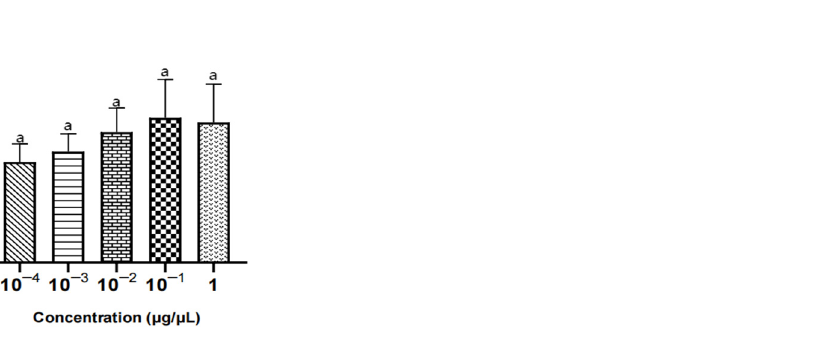
Figure 20. EAG responses of male W. magnifica to different concentrations of propyl butyrate. 3.3.2. EAG Results of three Compounds in Different Concentrations for Female W. mag-